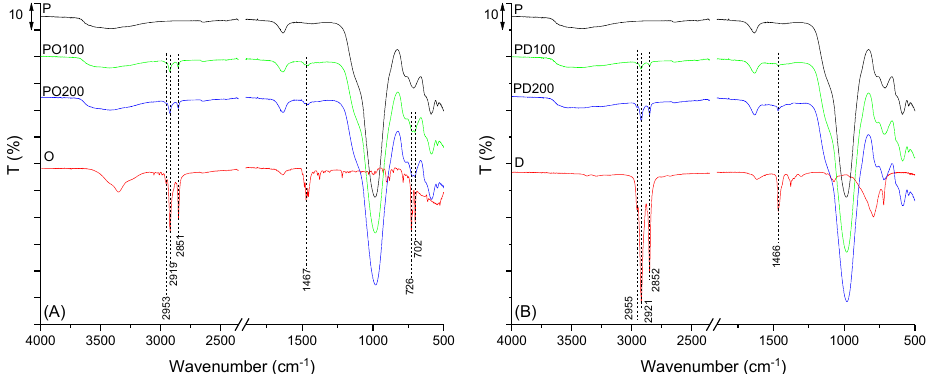
Figure 1. FTIR–ATR spectra of ( A ) starting material—P, surfactant octadecyldimethylbenzylammonium chloride—O, and composites PO100 and PO200; ( B ) starting material—P, surfactant dodecyl amine—D, and composites PD100 and PD200.